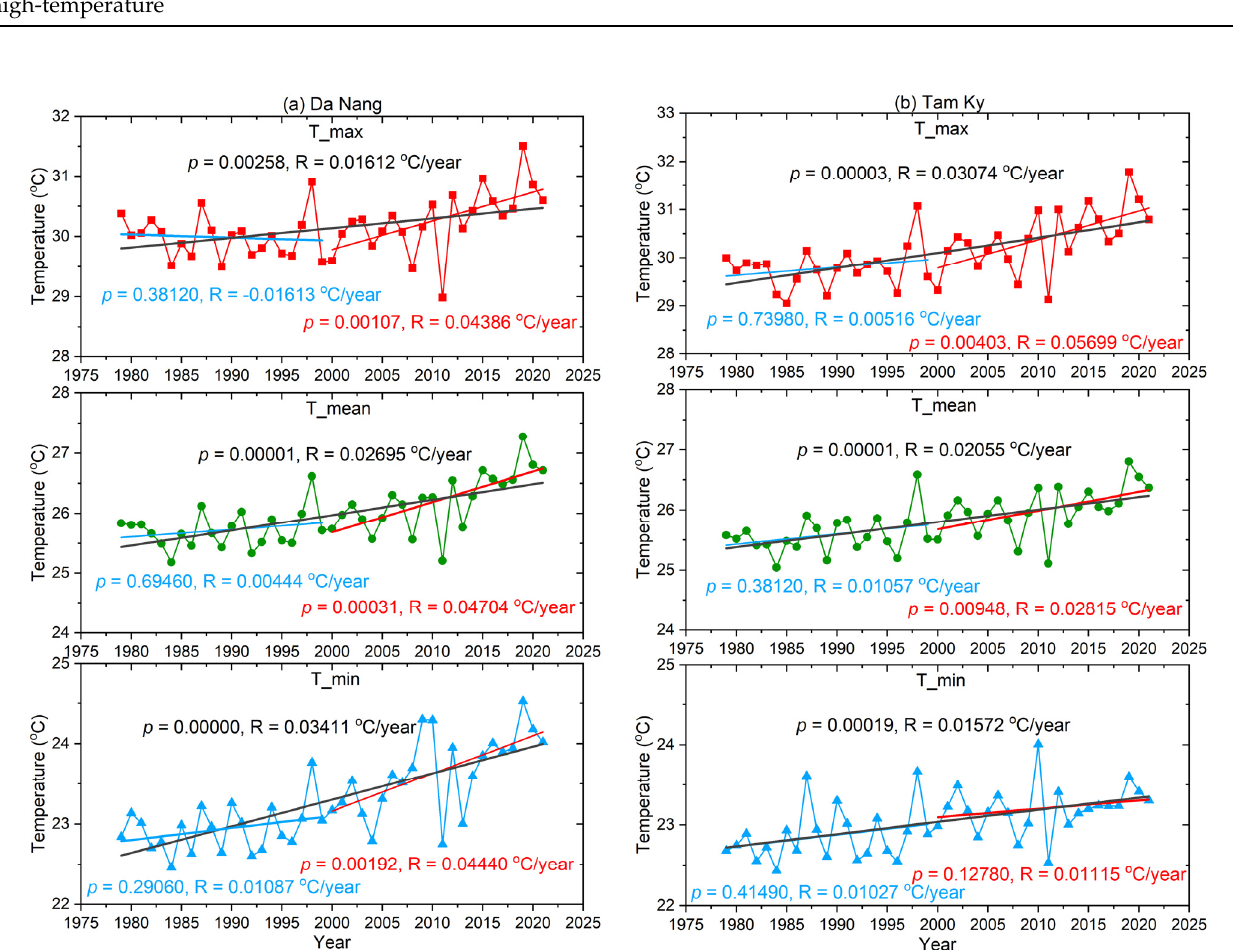
Figure 8. The maximum, mean, and minimum temperature trends in 1979–2021, 1979–1999, and 1999–2021 in ( a ) Da Nang meteorological station for Da Nang city; ( b ) Tam Ky meteorological station for Quang Nam province. p —statistically significant, R—Decreased/increased rates are the slopes of the linear regression. Table 3. Mann–Kendall test trend and Sen’s estimator results at the Da Nang meteorological station for Da Nang city.